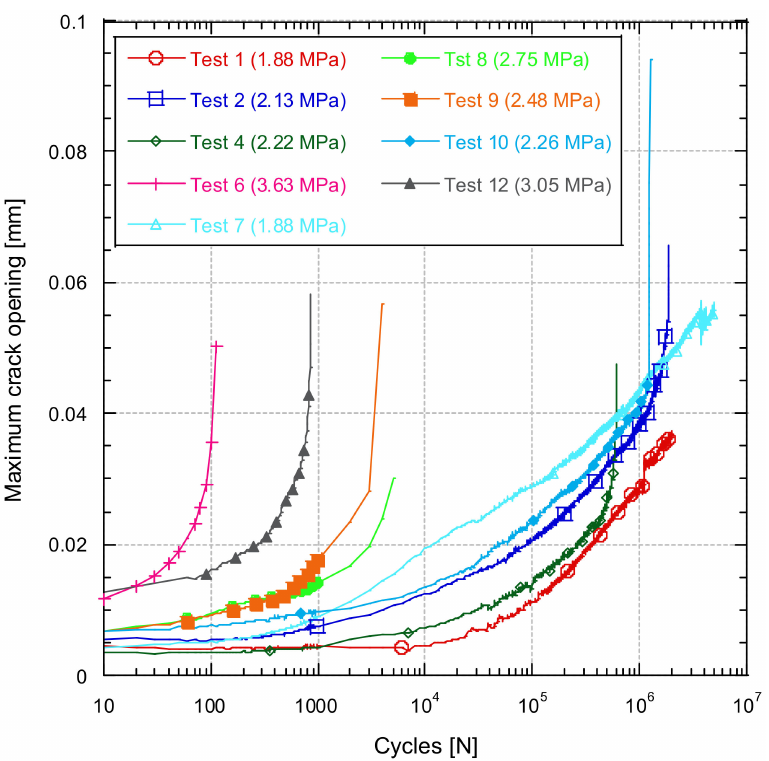
Figure 14. Evolution of the crack maximum opening as a function of the number of cycles.